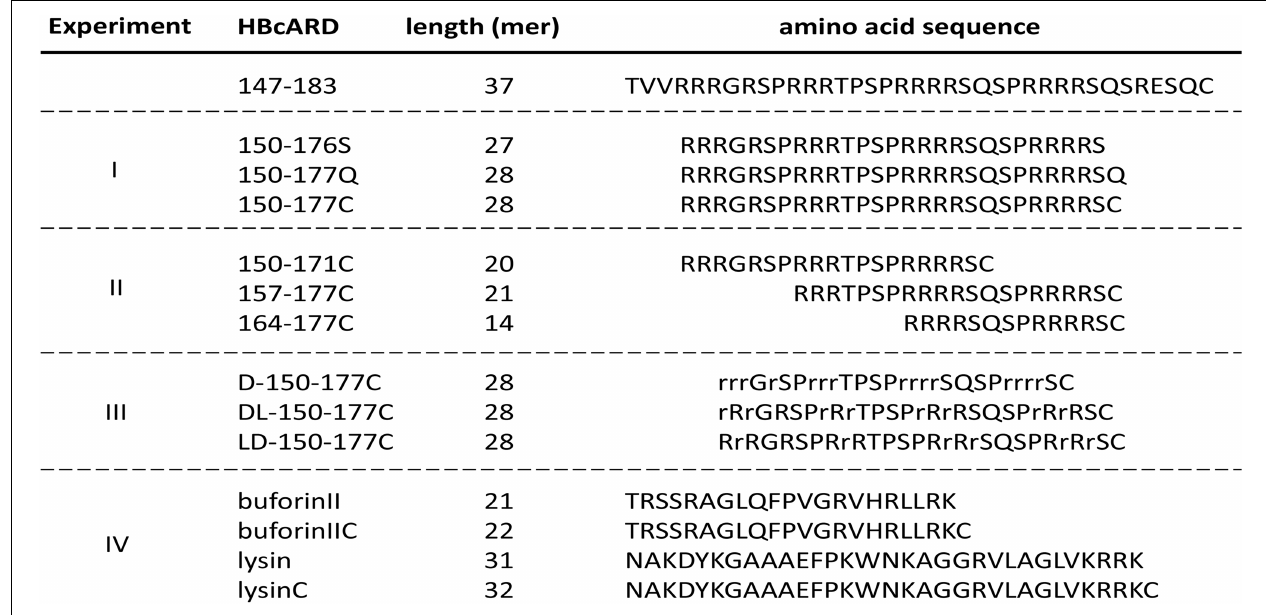
FIGURE 1 | Amino acid sequences of HBcARD peptides tested for bactericidal activity in this study. HBcARD 147-183 is the prototype peptide. The derivative peptides were synthesized for optimization of bactericidal activity in this study. Uppercase letters indicate L -form amino acids. Lowercase letters indicate D -form amino acids. For experiment-I, peptides with different C-terminal amino acid compositions (150-176S, 150-177Q, and 150-177C) were compared for the antibacterial activity in vitro and in vivo . For experiment-II, N-terminus- and C-terminus-truncated HBcARD peptides (150-171C, 157-177C, and 164-177C) were generated. These peptides contain different arginine contents. For experiment-III, peptides containing all- D -arginine or partial- D -arginine substitution (D-150-177C, DL-150-177C, and LD-150-177C) were compared for their respective bactericidal activity. For experiment-IV, peptides (buforinII, buforinIIC, lysin and lysinC) were compared for the enhancement of in vitro antibacterial activity by the CTC method. TABLE 1 | Minimum bactericidal concentration (MBC) of HBcARD peptides against various Gram-negative and Gram-positive bacteria. Bacteria strains MBC (mg/L) 147-183 150-176S 150-177C